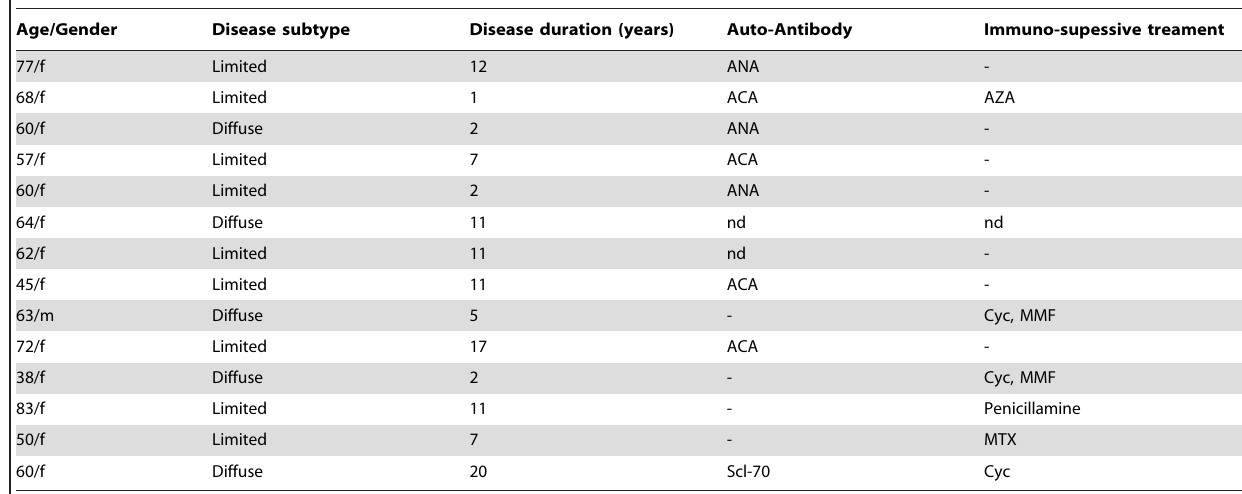
Table 1. Patient